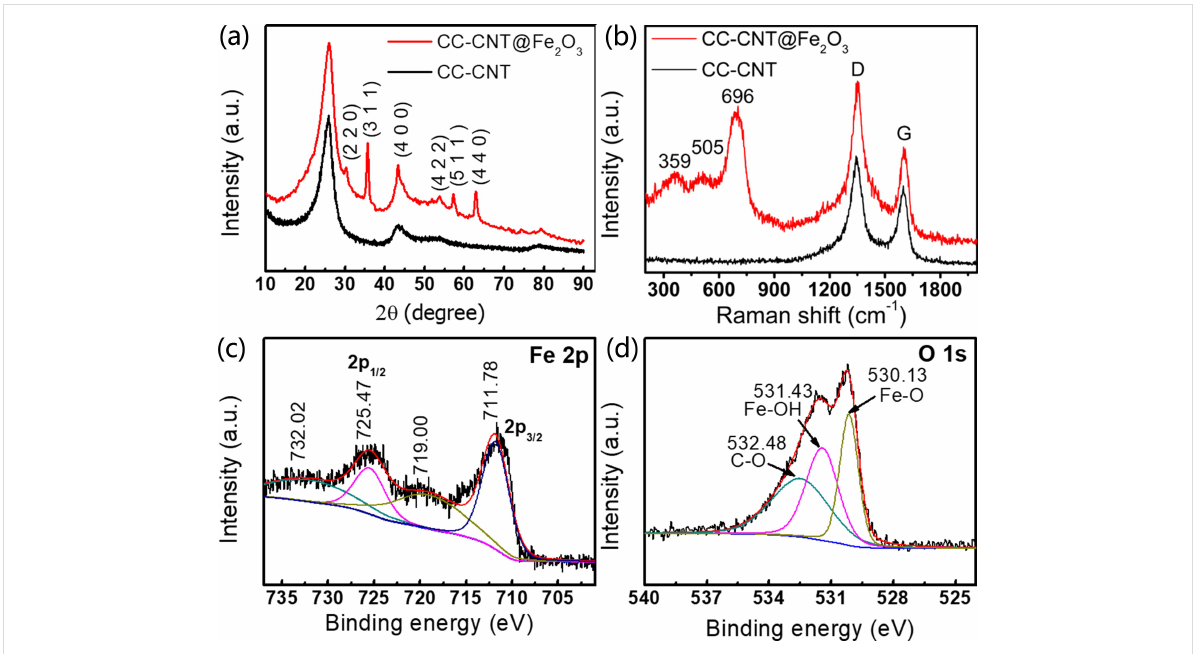
Figure 3: (a) XRD pattern and (b) Raman spectra of CC-CNT and CC-CNT@Fe 2 O 3 ; (c) Fe 2p and (d) O 1s XPS spectra of CC-CNT@Fe 2 O 3 .